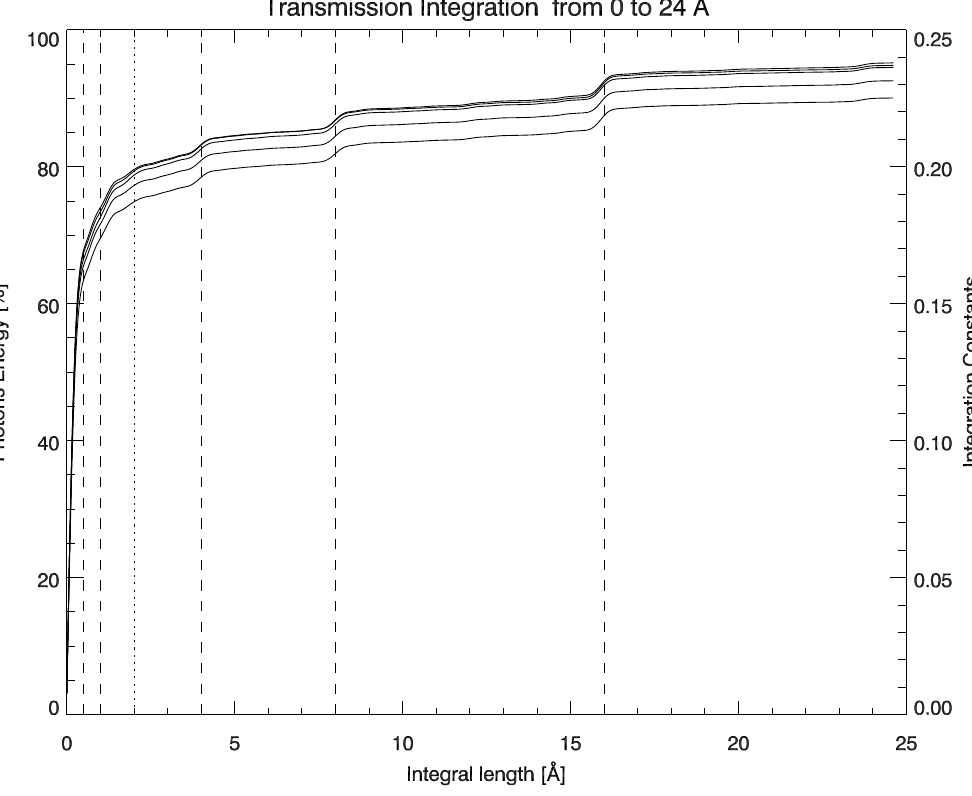
Figure 7. Integration variation with different wavelength range. The 80 % transmission photons concentrate in the profiles formed by the first three thickest elements. The increase of these curves slows down when the integration range approaches to the 32 Å. The integration value will be invariable on condition that the integration range is fixed on 32 Å, and also the effect of illuminating source should be largely removed from the